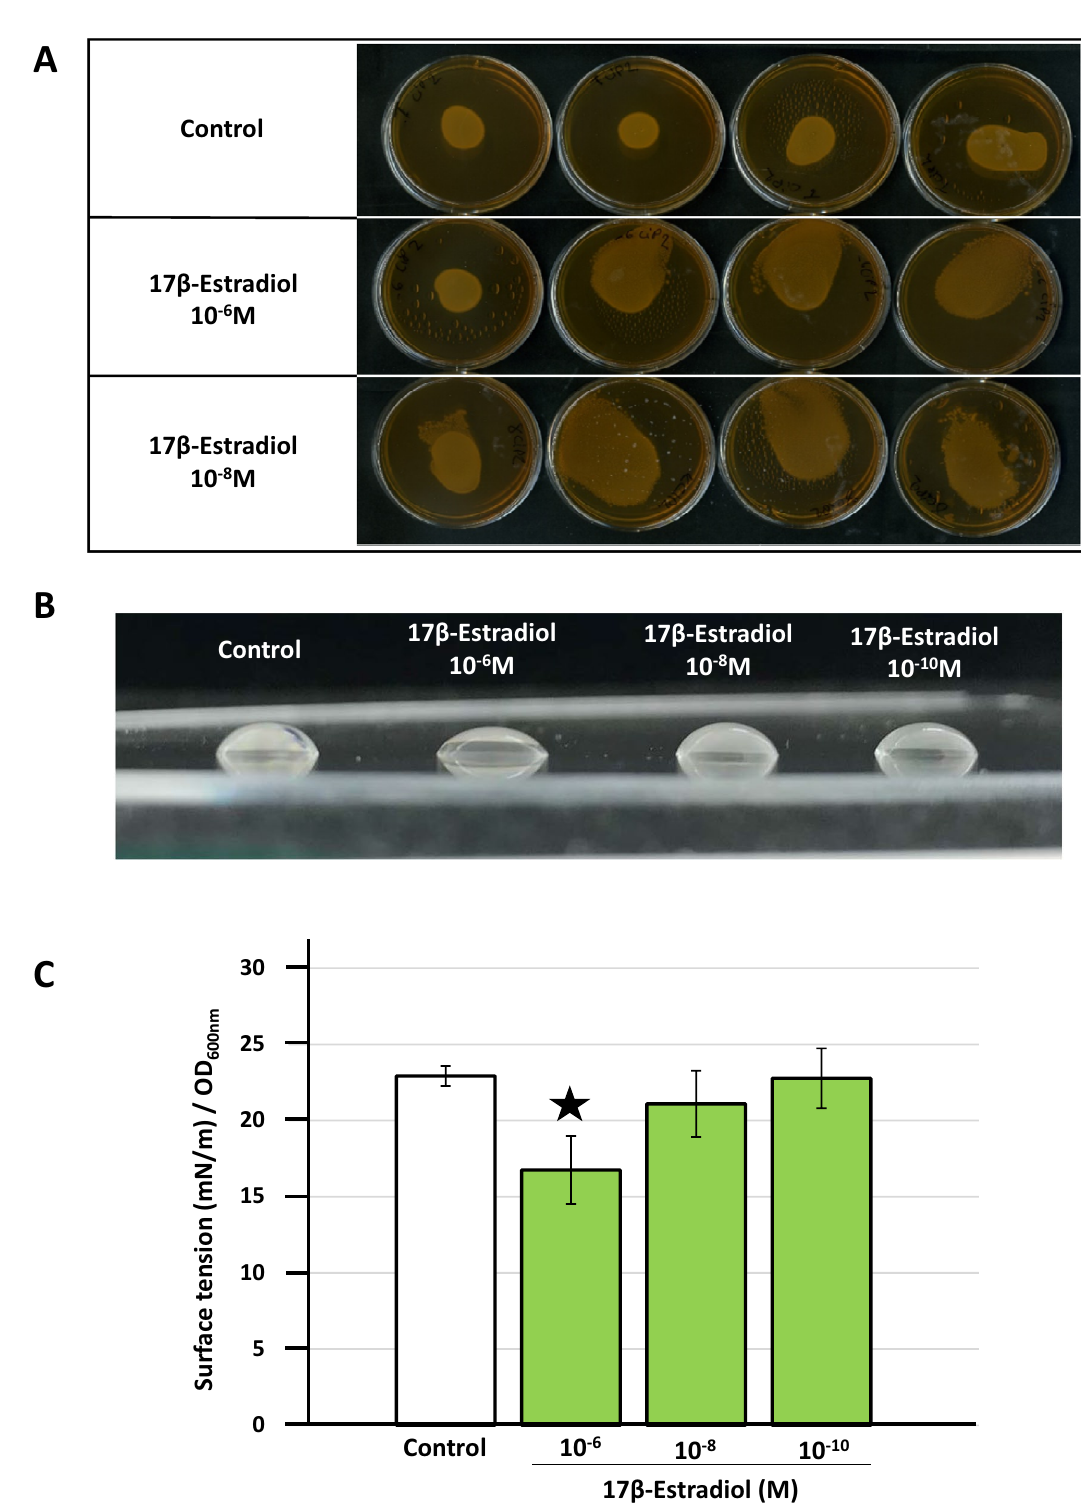
Figure 4. Effect of 17β-estradiol on Lactobacillus crispatus CIP104459 biosurfactant production. ( A ) Cultures of L. crispatus CIP104459 on MRS agar medium after exposure to 17β-estradiol (10 –6 and 10 –8 M). ( B ) Typical shape of drops of solution obtained after rinsing the bacterial lawn formed on Petri dishes in the presence or absence of 17β-estradiol (10 –6 , 10 –8 and 10 –10 M). ( C ) Surface tension value of solutions extracted from L. crispatus CIP104459 exposed to 10 –6 , 10 –8 and 10 –10 M 17β-estradiol, measured by the pendant drop method. Values are the means ± SEM of three independent experiments. (* = p <